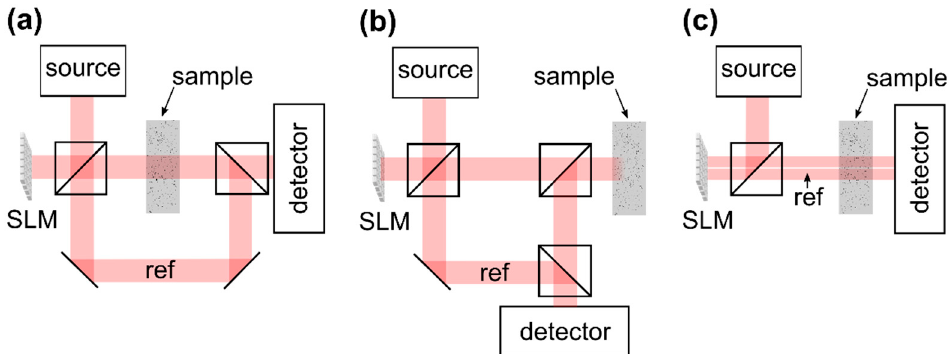
Figure 7. Experimental designs for transmission matrix acquisition. ( a ) Transmission geometry with external reference beam. ( b ) Reflection geometry with reference beam. ( c ) Self-referenced transmission geometry. Abbreviations: SLM—spatial light modulator, ref—reference beam. Image from [8], with permission.